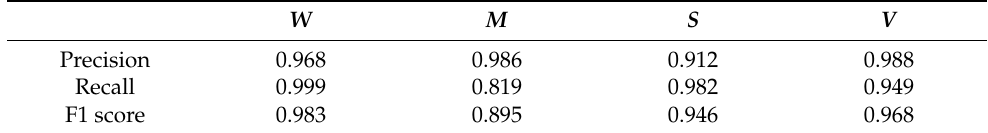
Table 8. Performance metrics estimated for L8 land cover